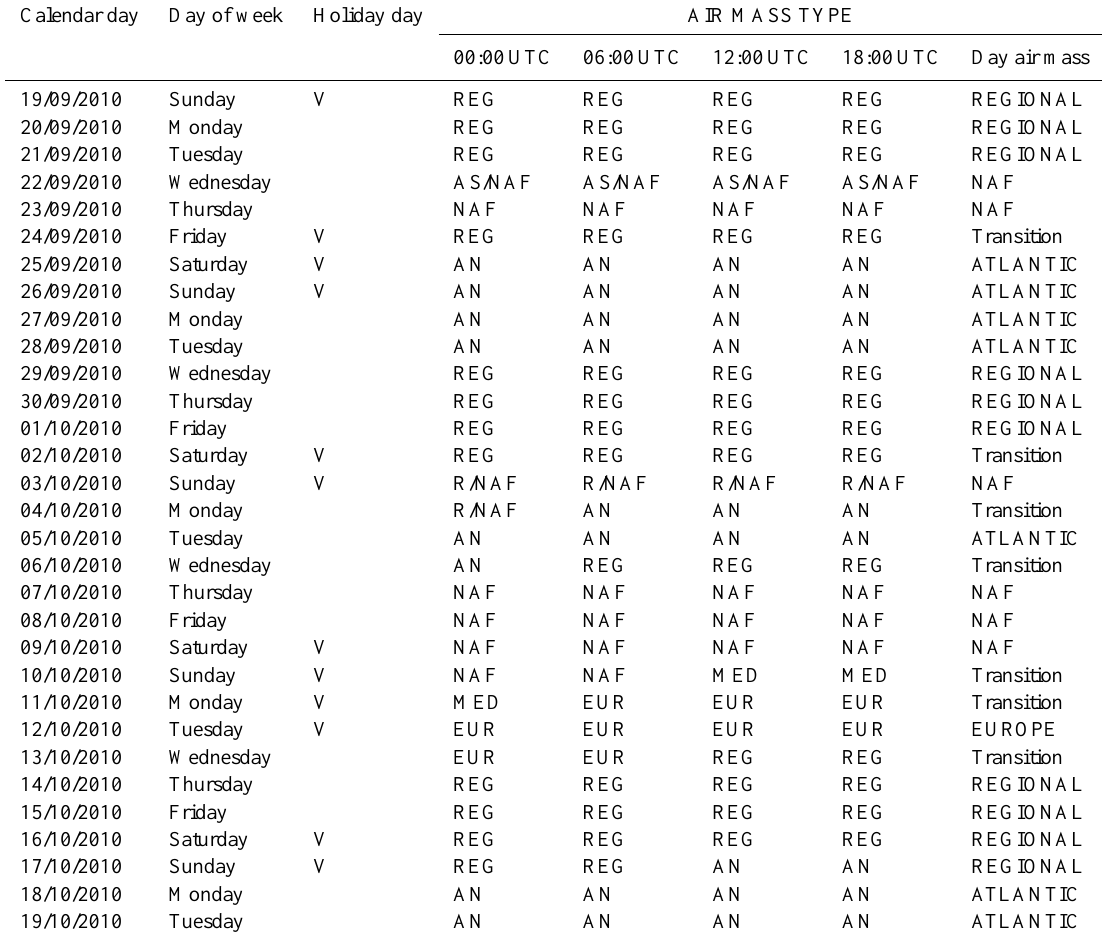
Table 3. Classification of air mass origins during